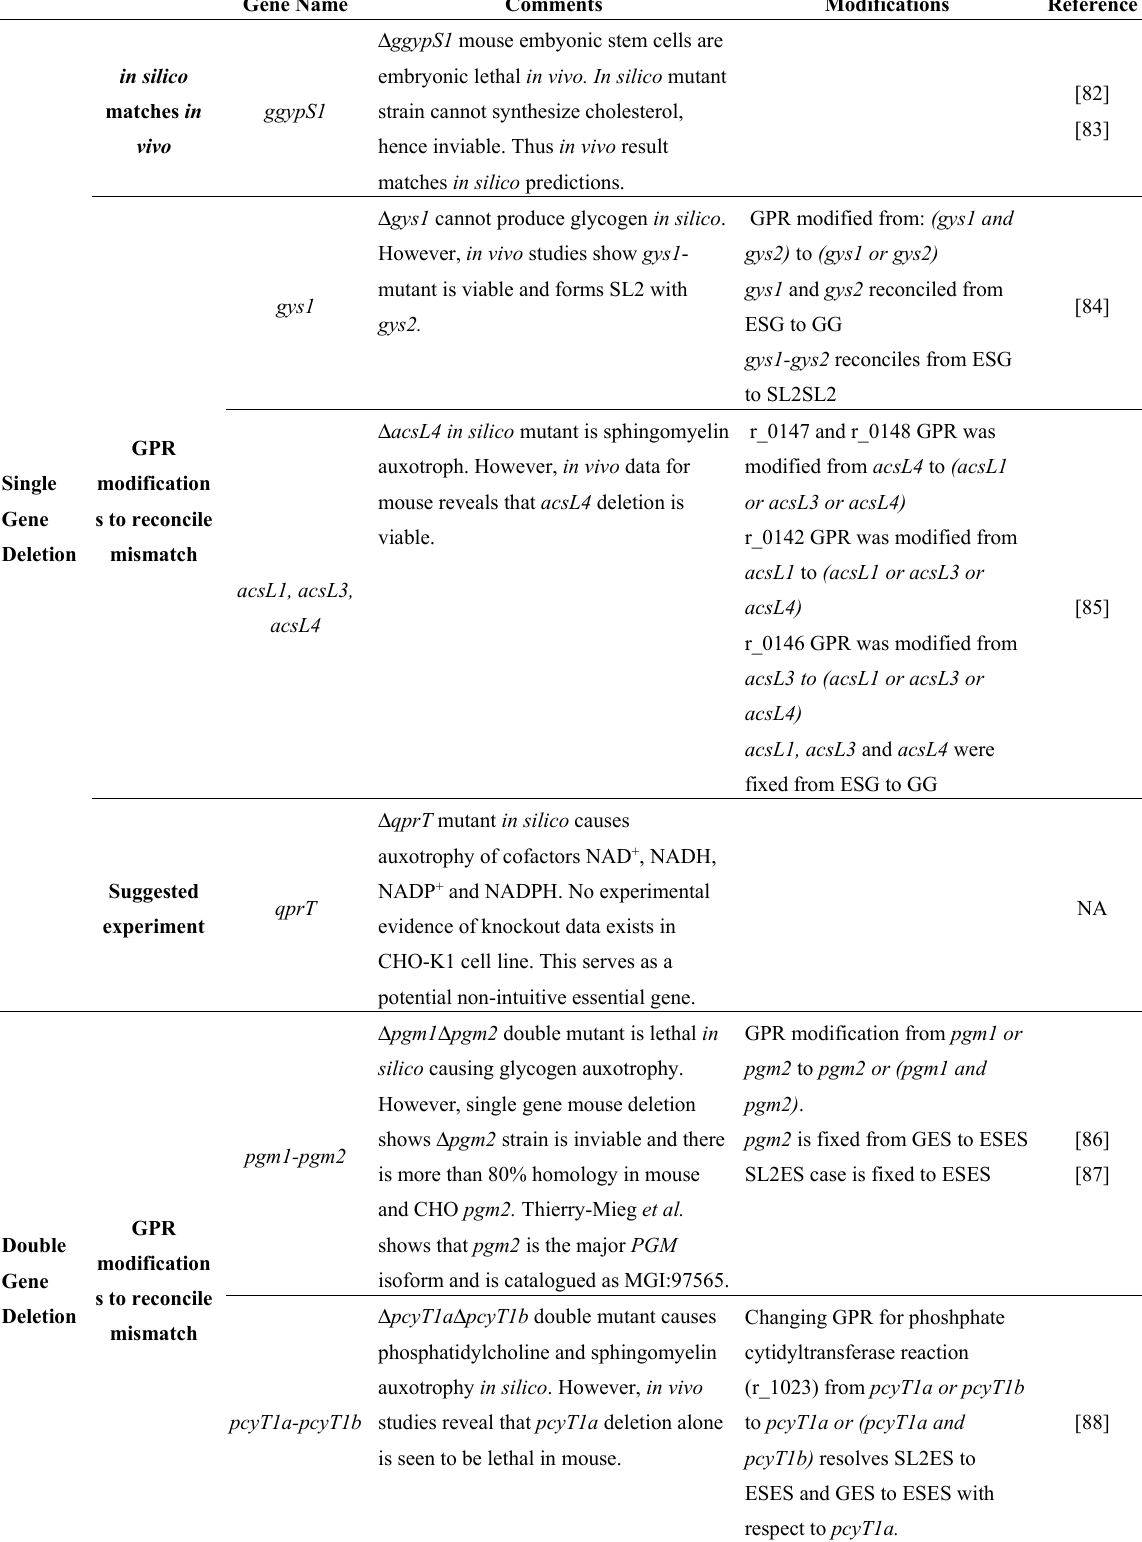
Table 6. CHO 1.2 model essentiality and lethality comparisons with in vivo data and suggested gene deletion